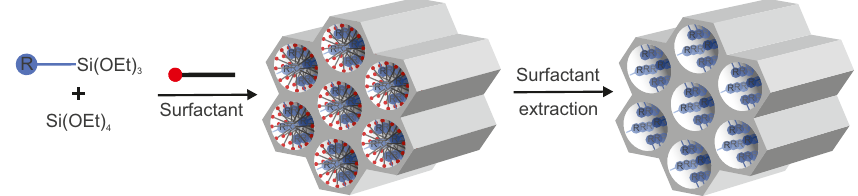
Figure 16. A general scheme of